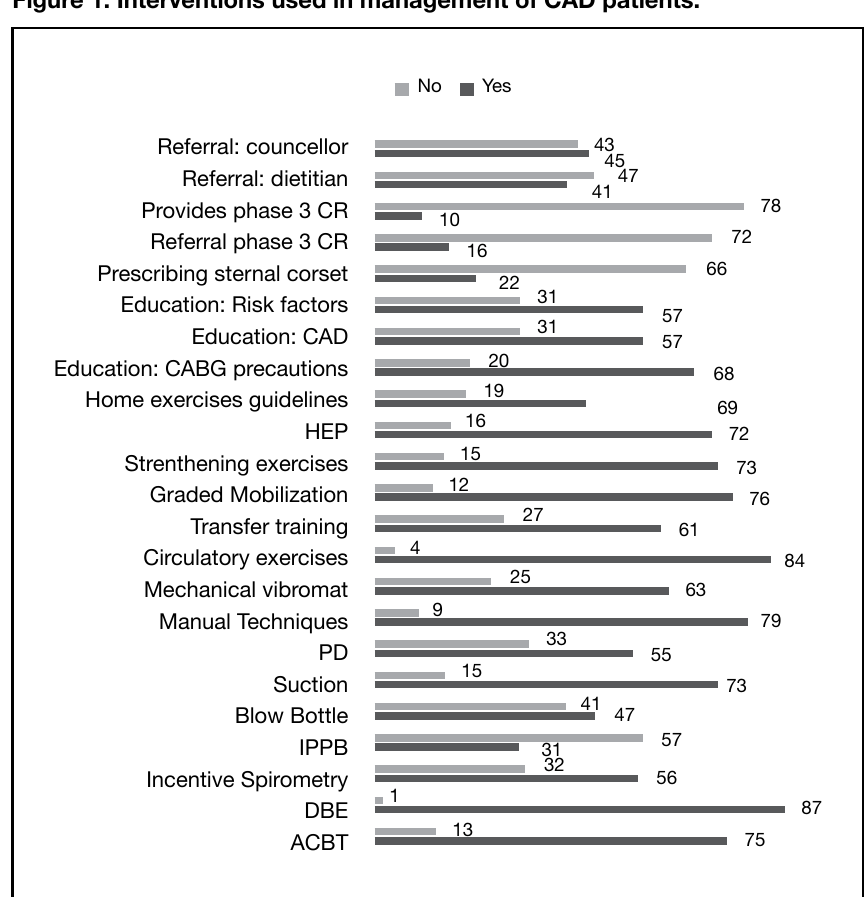
Figure 1: interventions used in management of cAD